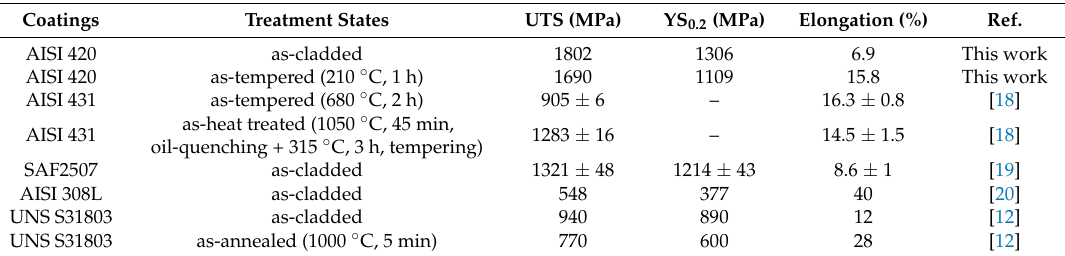
Table 2. Comparison of the Tensile Properties from different laser cladded Fe-based SS coatings.